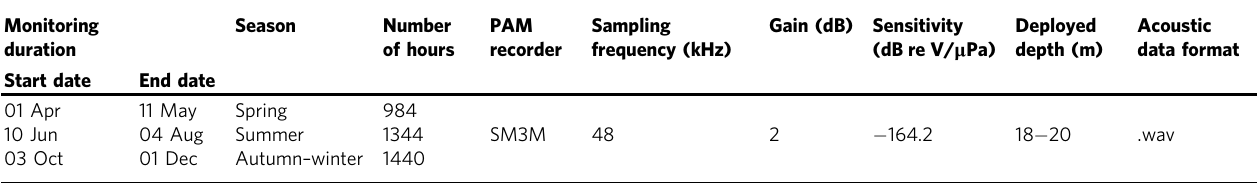
Table 2 Passive acoustic monitoring device speci fi cations and monitoring duration during different seasons. Monitoring